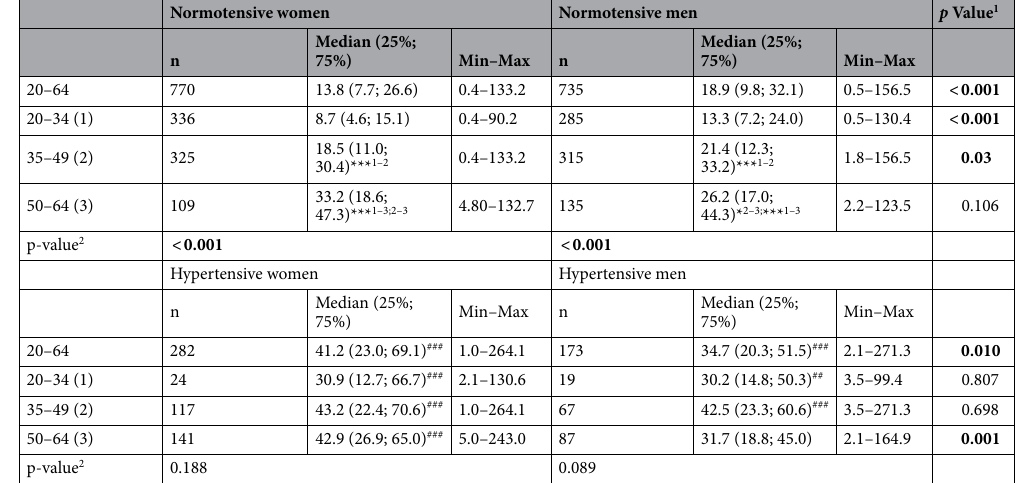
Table 2. LAP values according to age subgroups in women and men with and without hypertension. Bold values indicate p < 0.05 1 The statistical significance of differences between men and women was estimated using the Mann–Whitney test. 2 The statistical significance of differences between age groups was estimated using the Kruskal–Wallis test. Differences between age groups are statistically significant at * p < 0.05 and *** p < 0.001 (multiple comparisons by Dunn test). ## p < 0.01; ### p < 0.001 – The statistical significance of differences between normotensive and hypertensive subjects within each corresponding age group.